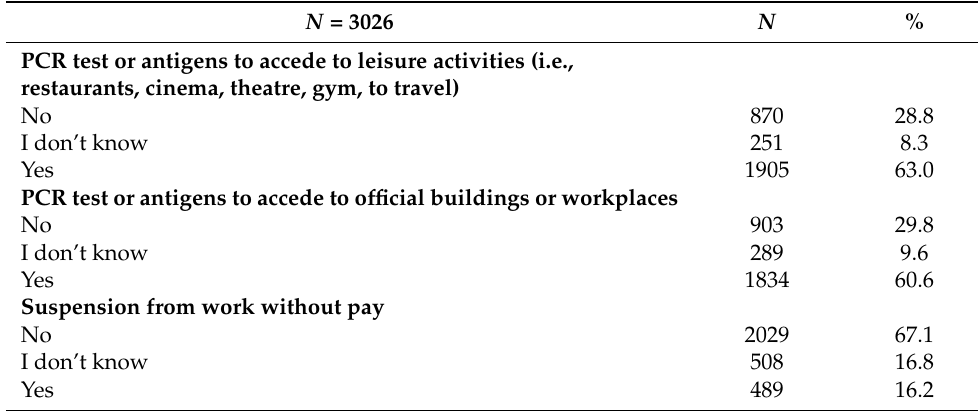
Table 2. Percentage of agreement with possible measures to promote vaccination. N = 3026 N % PCR test or antigens to accede to leisure activities (i.e.,